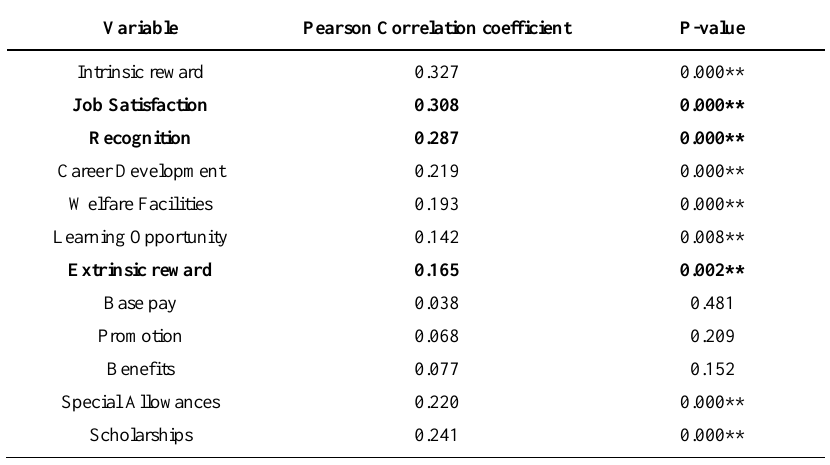
Table 4. Association between Overall Work Commitment and Composite Intrinsic Reward Scores and Extrinsic Reward Scores